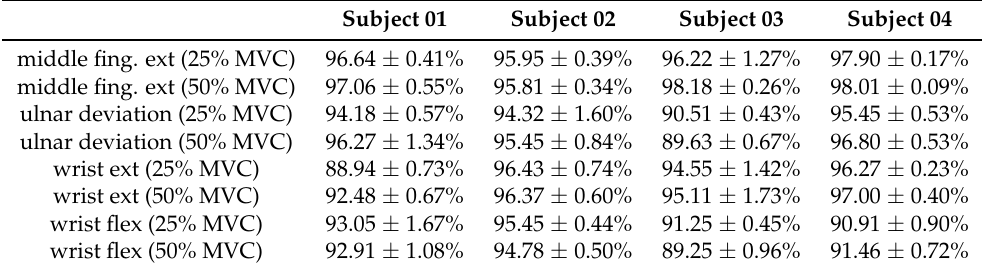
Table 2. Goodness of Fit (GOF) value of the reconstructed sEMG value on the electrode space in terms of Normalized Root Mean Square Error